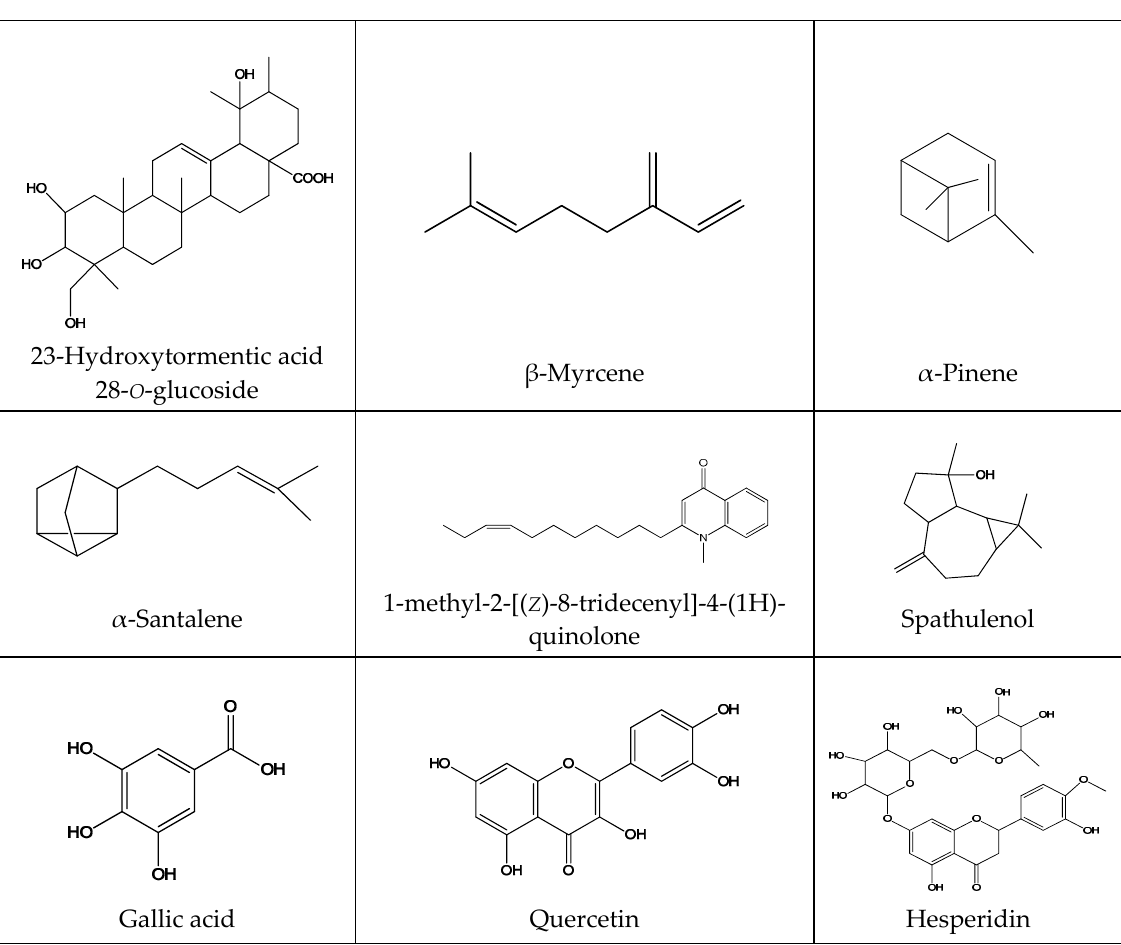
Figure 1. Structure of some phytochemicals evaluated as antiulcer agents.